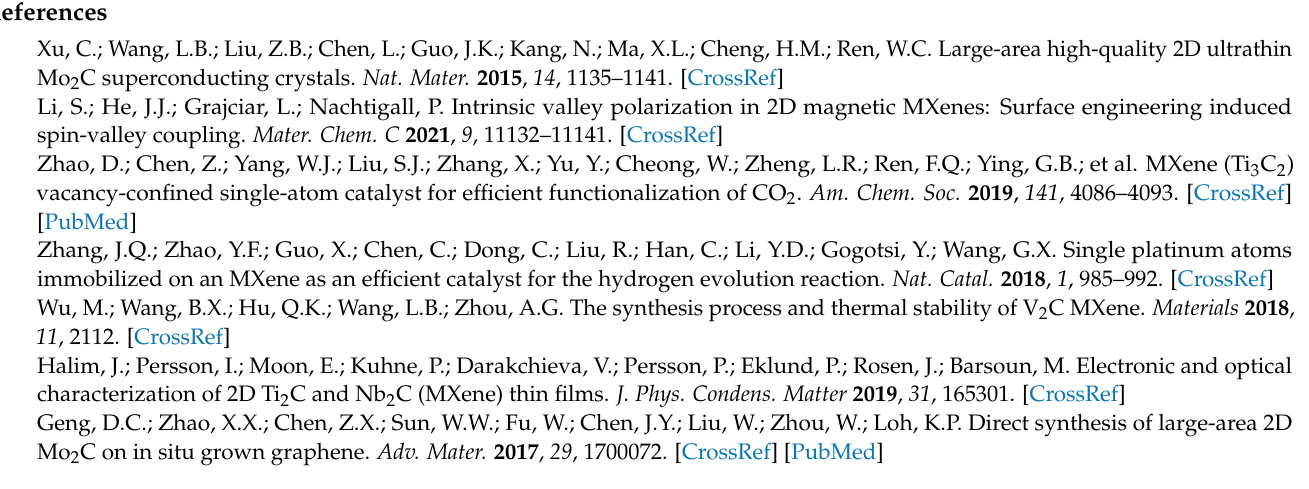
Cu-Ta; Figure S2: SEM and EDS of Mo wire and Ta foil after diffusion; Figure S3: The schematic diagram of orthorhombic and cubic MTC growth processes; Figure S4: Optical image and Raman of Mo 2 C; Figure S5: The optical images of orthorhombic and cubic MTC with different Mo/Ta atomic fraction of Ta and temperature. The scale bar is 20 µ m. Table S1: Main characterizations of different synthetic technologies for TMCs